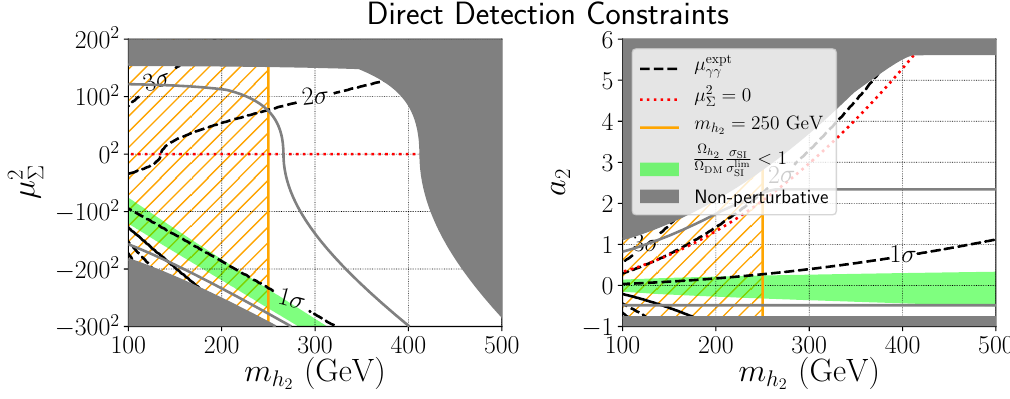
Figure 5. The region of parameter space consistent with the current XENON1T direct detection limit as a function of m h and either (cid:22) 2 (left) or a 2 (right). The allowed parameter-space is shown (cid:6) 2 as a green band. The solid grey region is the parameter-space where the scalar couplings become non-perturbative at energies (cid:3) < 1 TeV, and the solid grey line shows where this contour would be if the cuto(cid:11) energy is increased to (cid:3) = 10 6 GeV. The black lines indicate the diphoton rate contours as in (cid:12)gure 2. The hashed orange region is the lower bound on m h from disappearing 2 tracks that was obtained in section 3.1. The red dotted line is the (cid:22) 2 = 0 (cid:6)